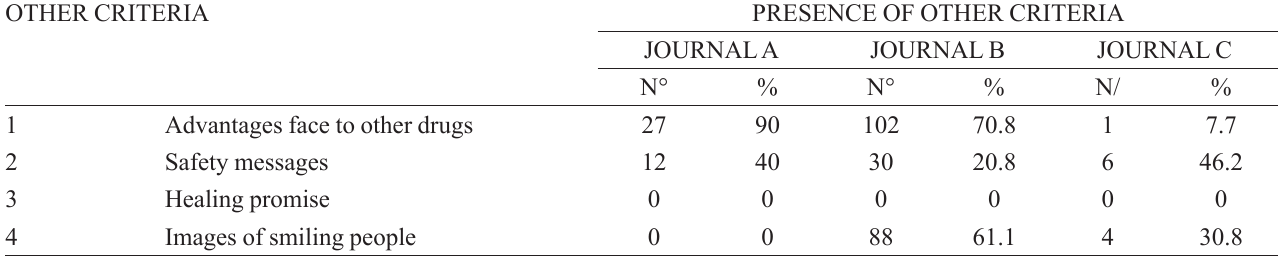
TABLE III – Evaluation of other criteria per journal OTHER CRITERIA